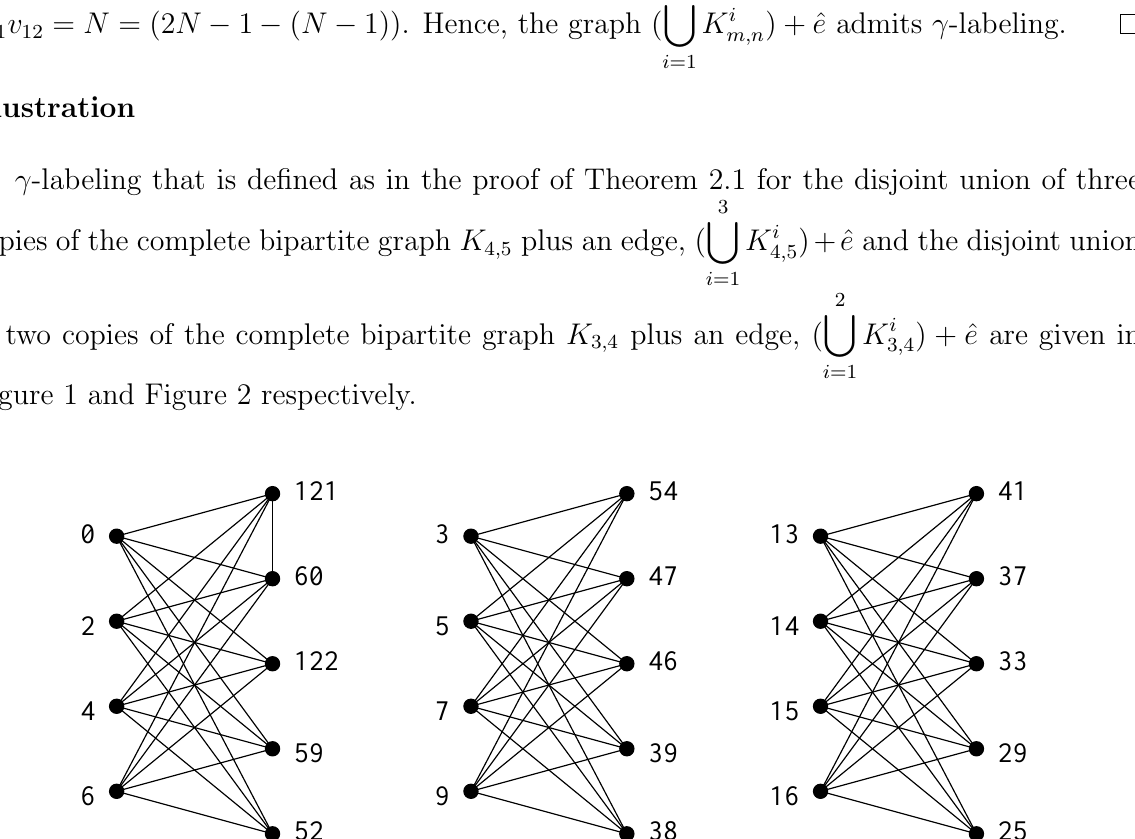
Figure 1: γ -labeling of